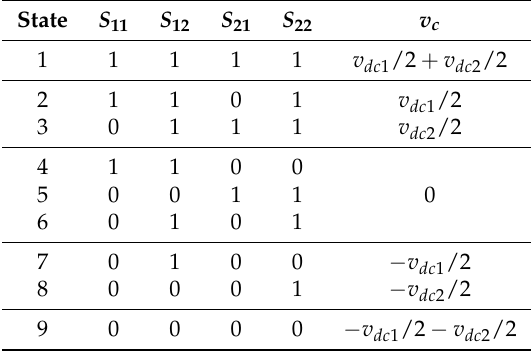
Table 1. Switching states and output voltage in the AC